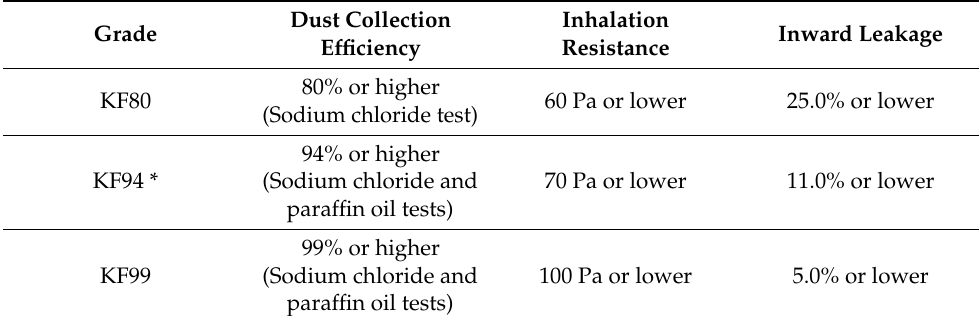
Table 1. KF mask certification grades and standards. Dust Grade